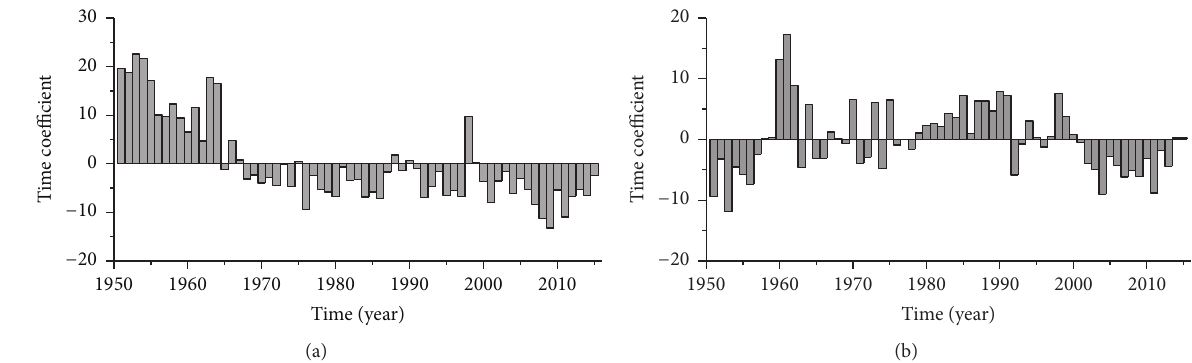
Figure 5: Time coefficients corresponding to the (a) first and (b) second eigenvector.